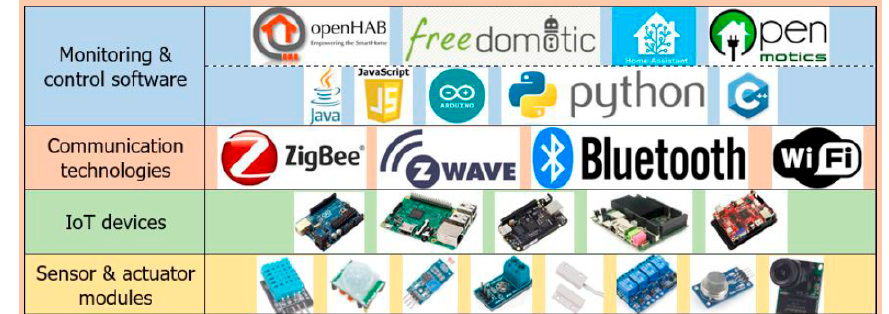
Figure 2. Information and Communication Technology (ICT) components for data acquisition in Smart Energy-Efficient Buildings (SEEB).